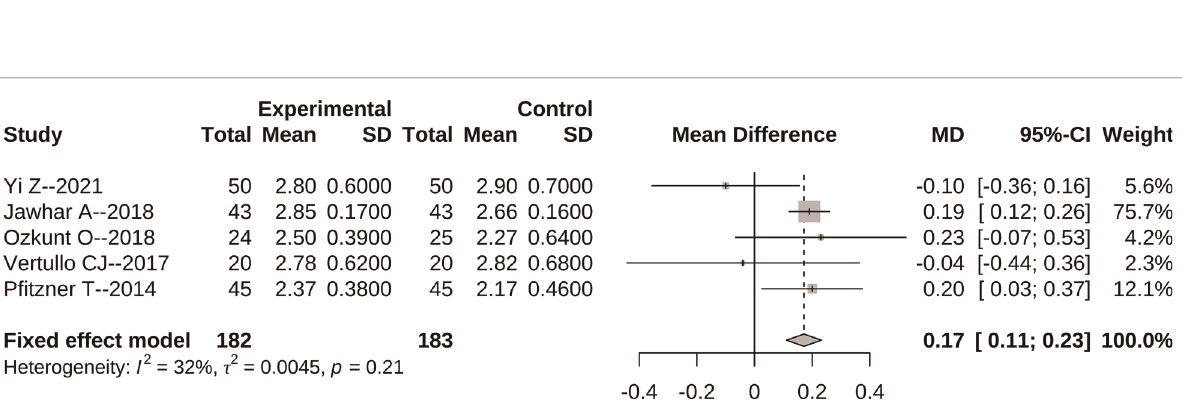
FIGURE 5 Forest plot for comparison of bone cement mantle thickness between the tourniquet (experimental) and non-tourniquet (control) groups. The I 2 was 32%, and the fi xed-effect model was